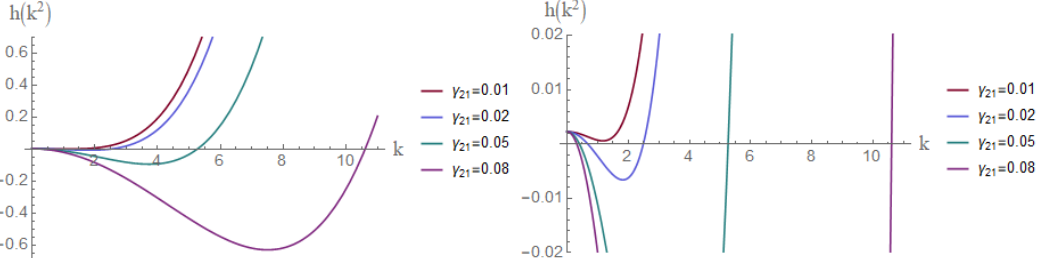
Figure 4. In the left panel , plots of h ( k 2 ) as a function of the wavenumber k for different values of the bifurcation parameter γ 21 ; in the right panel , a detail of the same plots. Here again α = 2.5, r = 0.18,